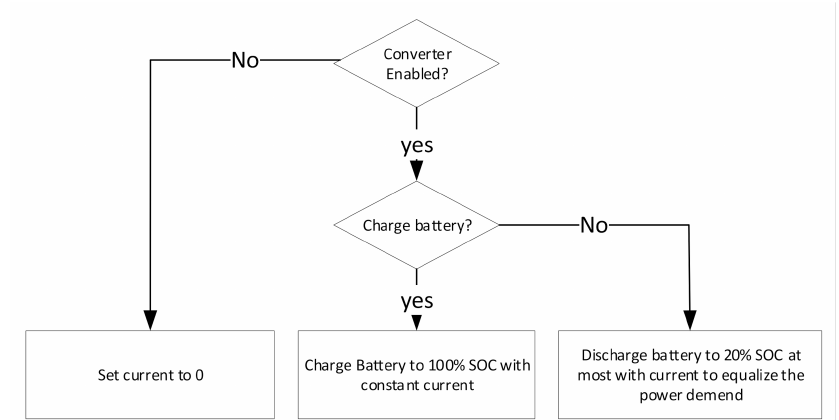
Figure 13. A flowchart discussing the algorithm of the converter connected to the EV.